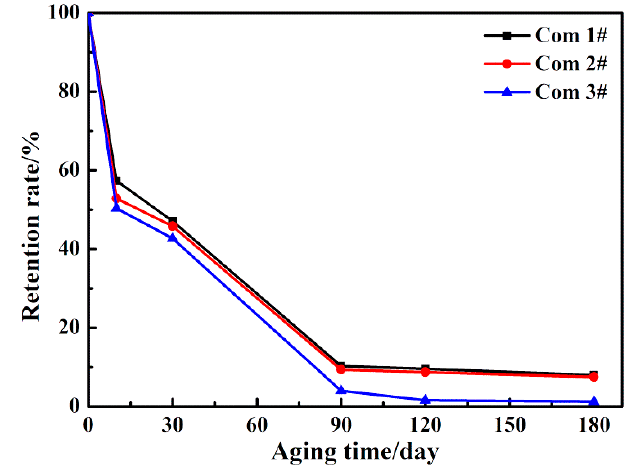
Figure 8. The inter-laminar shear strength (ILSS) retention rates of the three composites at 250 °C for different aging periods.